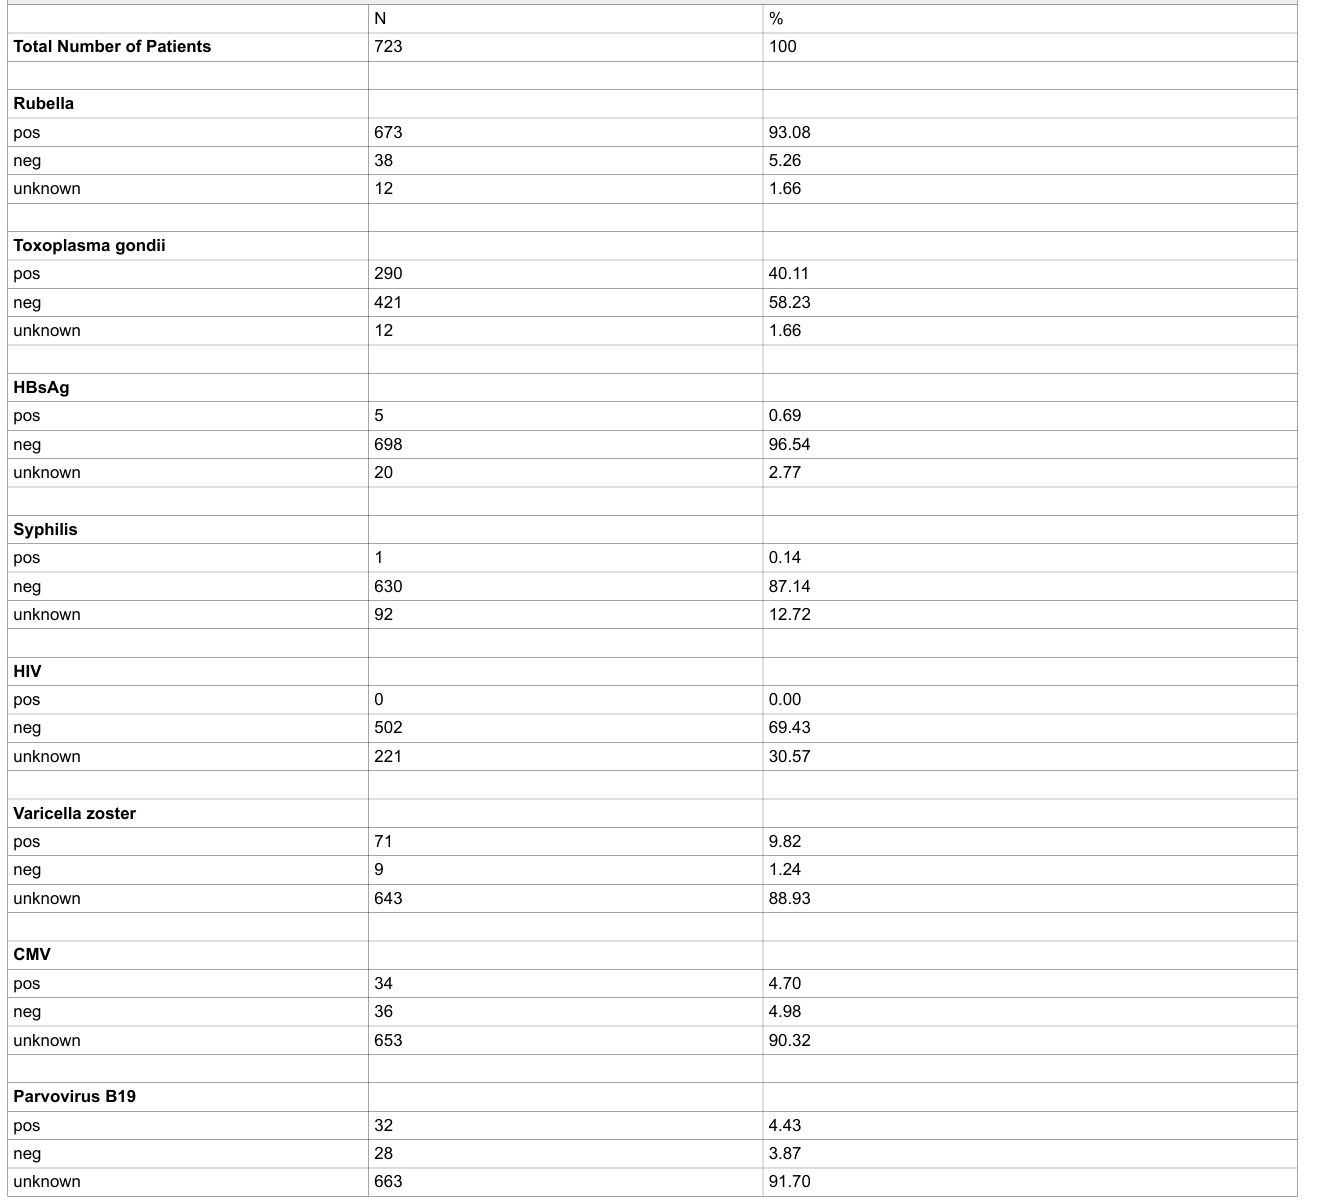
Table 1: Positive and negative findings in the serologies of the pregnant